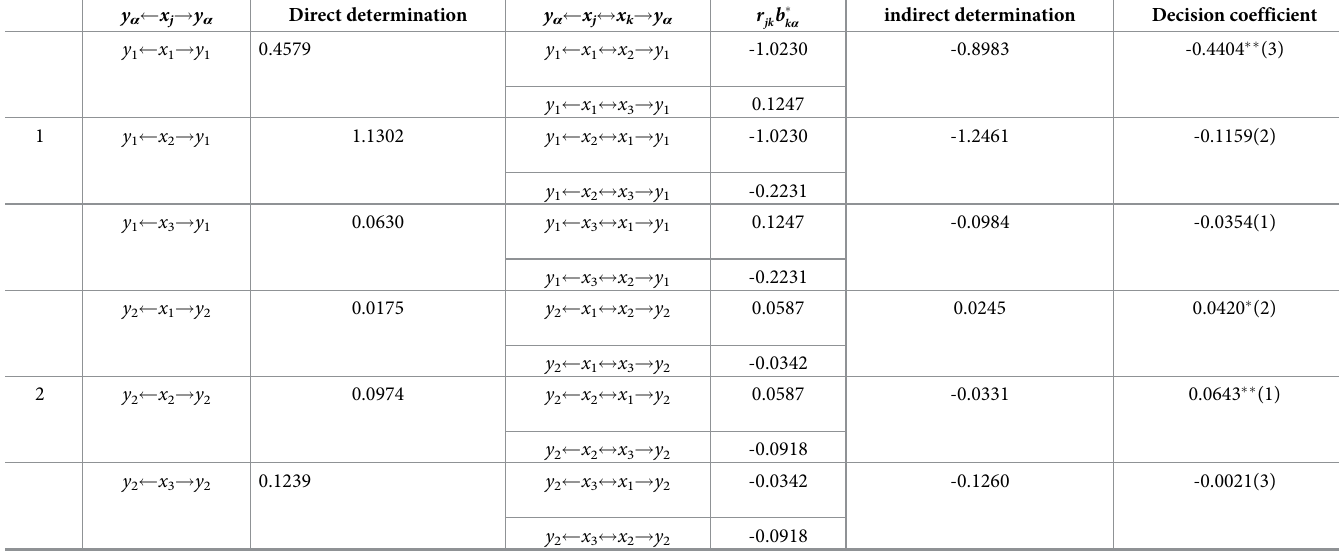
¼ β � T ð α ¼ 1 ; 2 ; 3 Þ x þ ε α α α